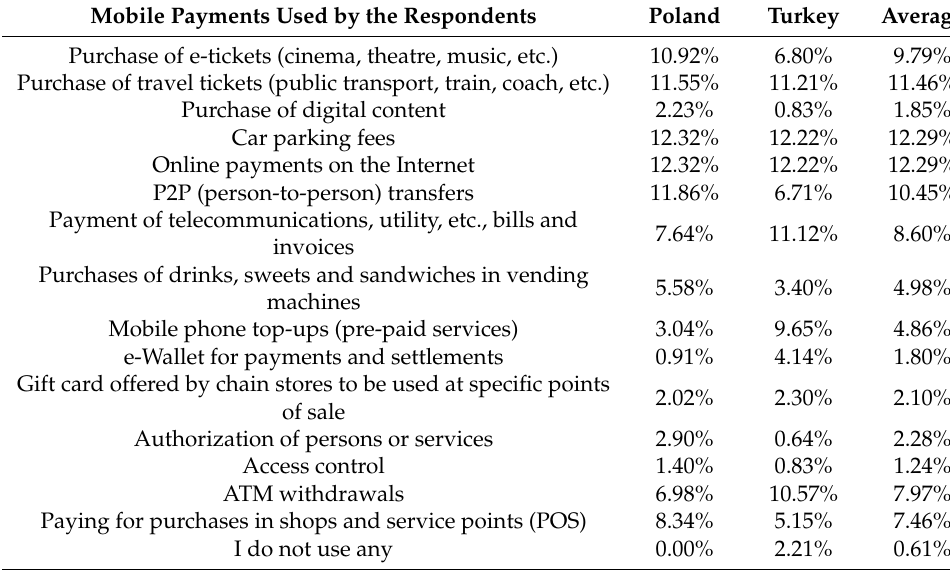
Table 5. Mobile payments used by the respondents; source: own work. Mobile Payments Used by the